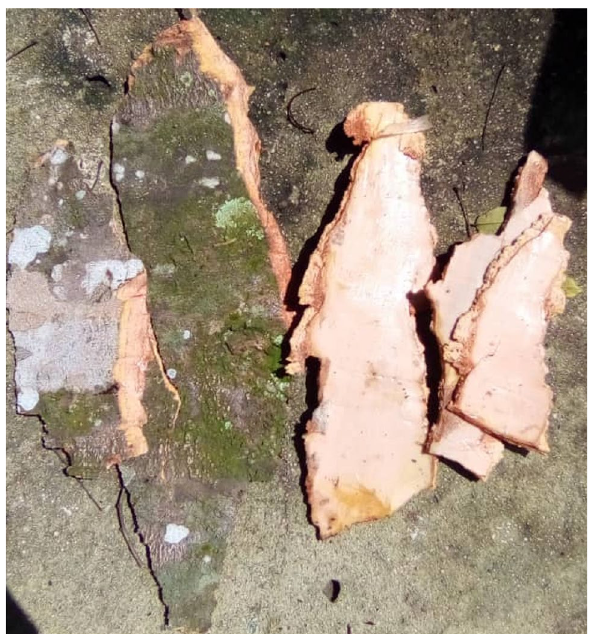
Figure 1. The stem bark of Dalium